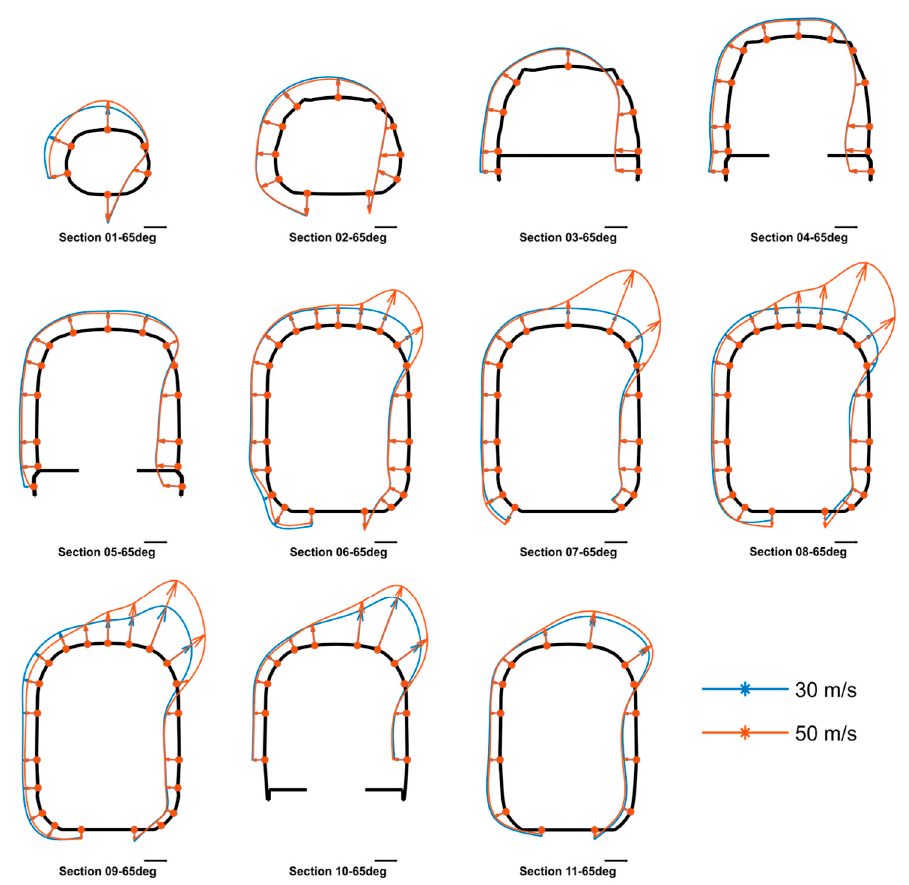
Figure 7. Pressure coefficient around the surface of the train. Wind tunnel test: wind speed 30 m/s and 50 m/s; wind yaw angle = 65°; train: ETR1000; scenario: STBR.